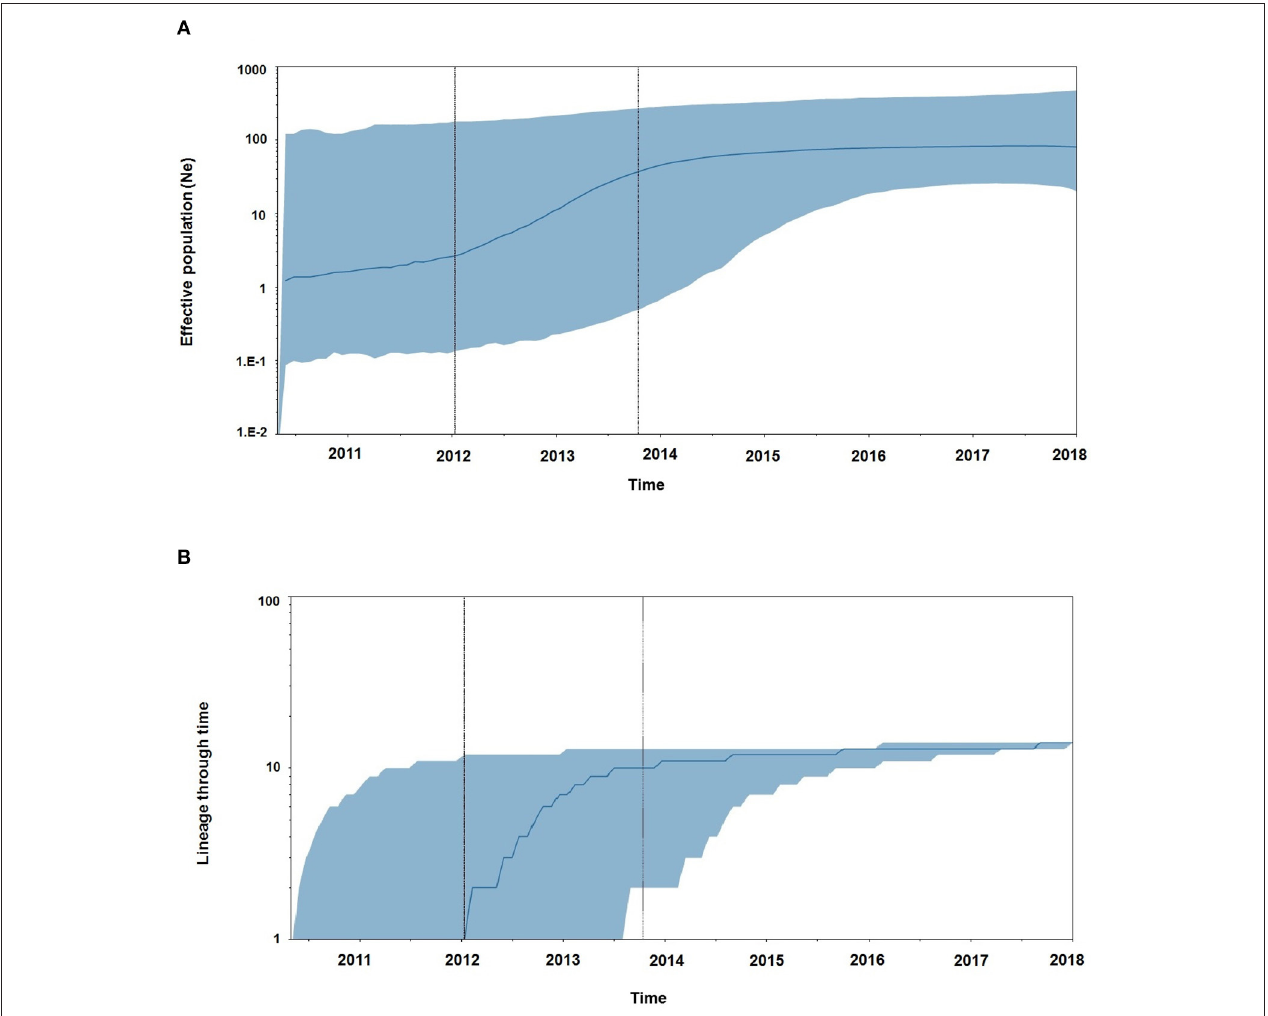
FIGURE 5 | (A) The Bayesian skyline plots derived using pol gene region representing the estimates of effective population size in a log scale over time for the Unnao transmission cluster. The solid line represents the median estimates while the gray-shaded area indicates the 95% HPD. Vertical lines represent the estimated lower and median 95% HPD pertaining to time scale. (B) Lineage through time plot displaying the cumulative number of linages (infections) over